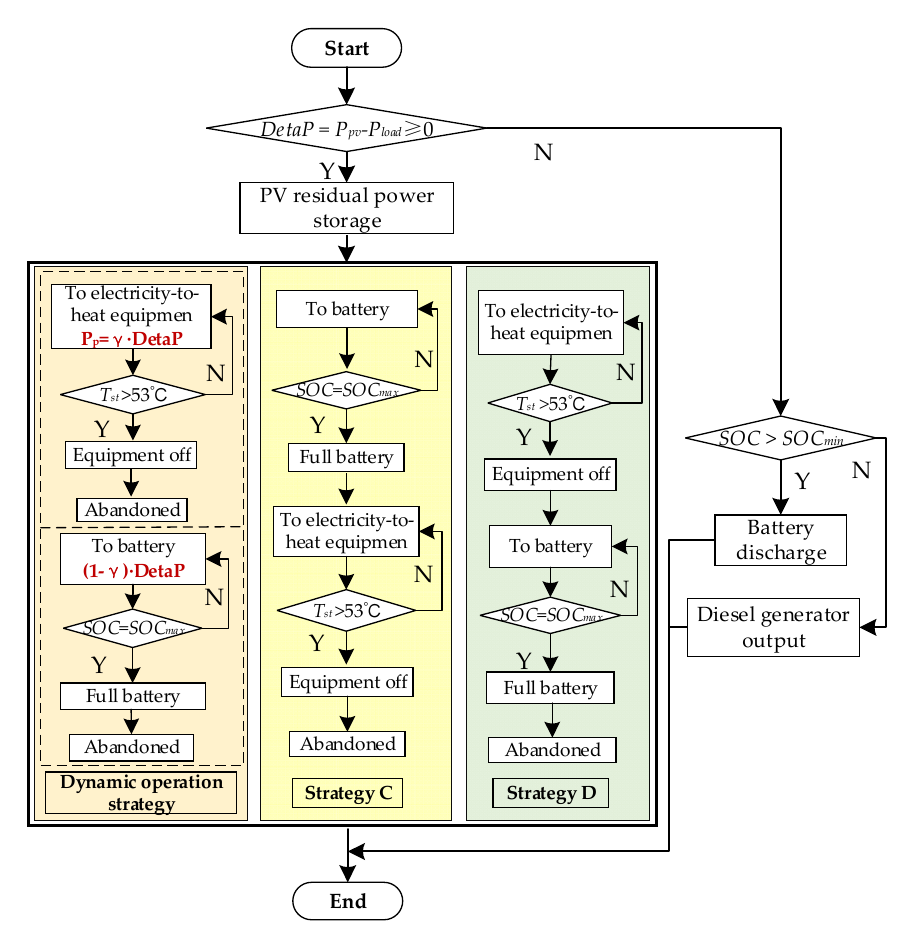
Figure 3. System operation strategy in the off-grid scenario.